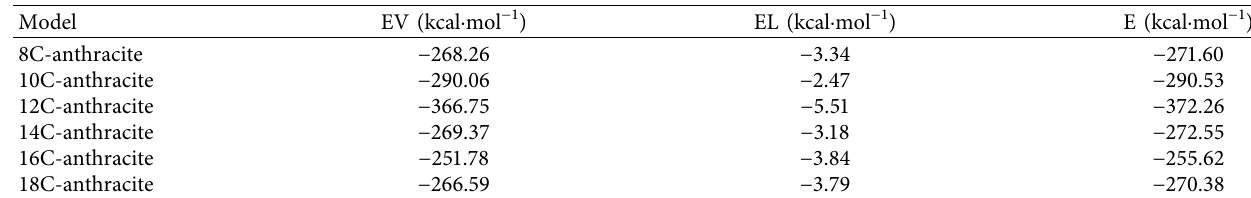
Table 3: Adsorption energy between surfactant and